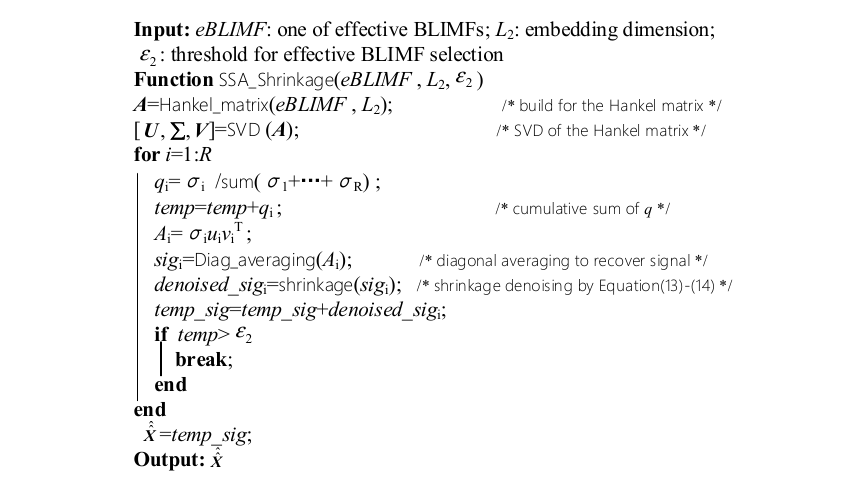
Algorithm 2 : Pseudo-code of the proposed SSA-based Shrinkage denoising method